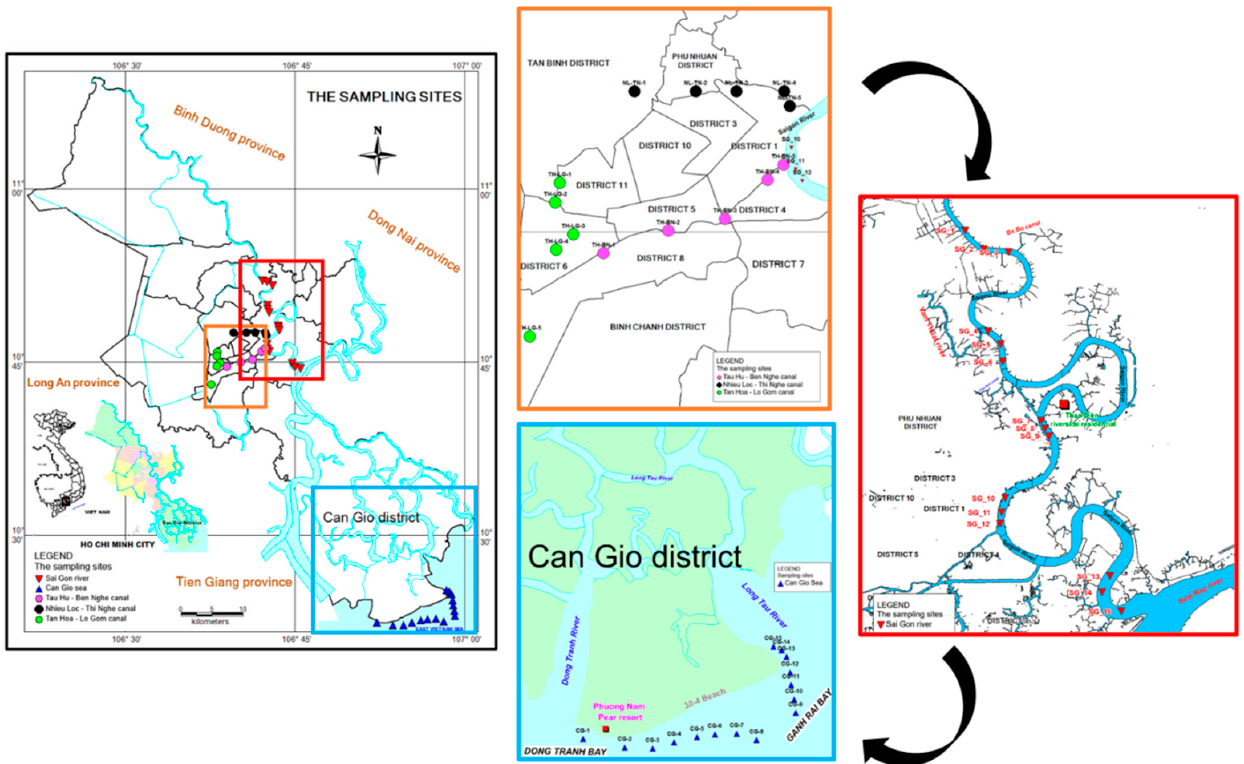
Figure 1. Sampling map of surface water MPs in HCMC, Vietnam, in August 2020.